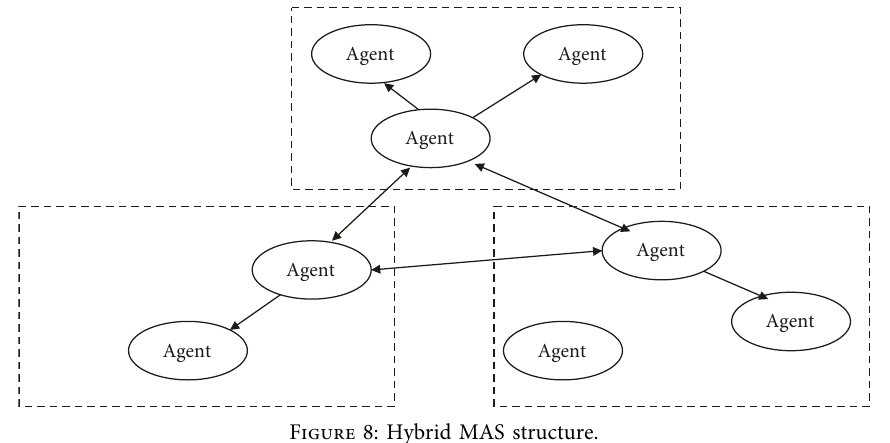
Figure 8: Hybrid MAS